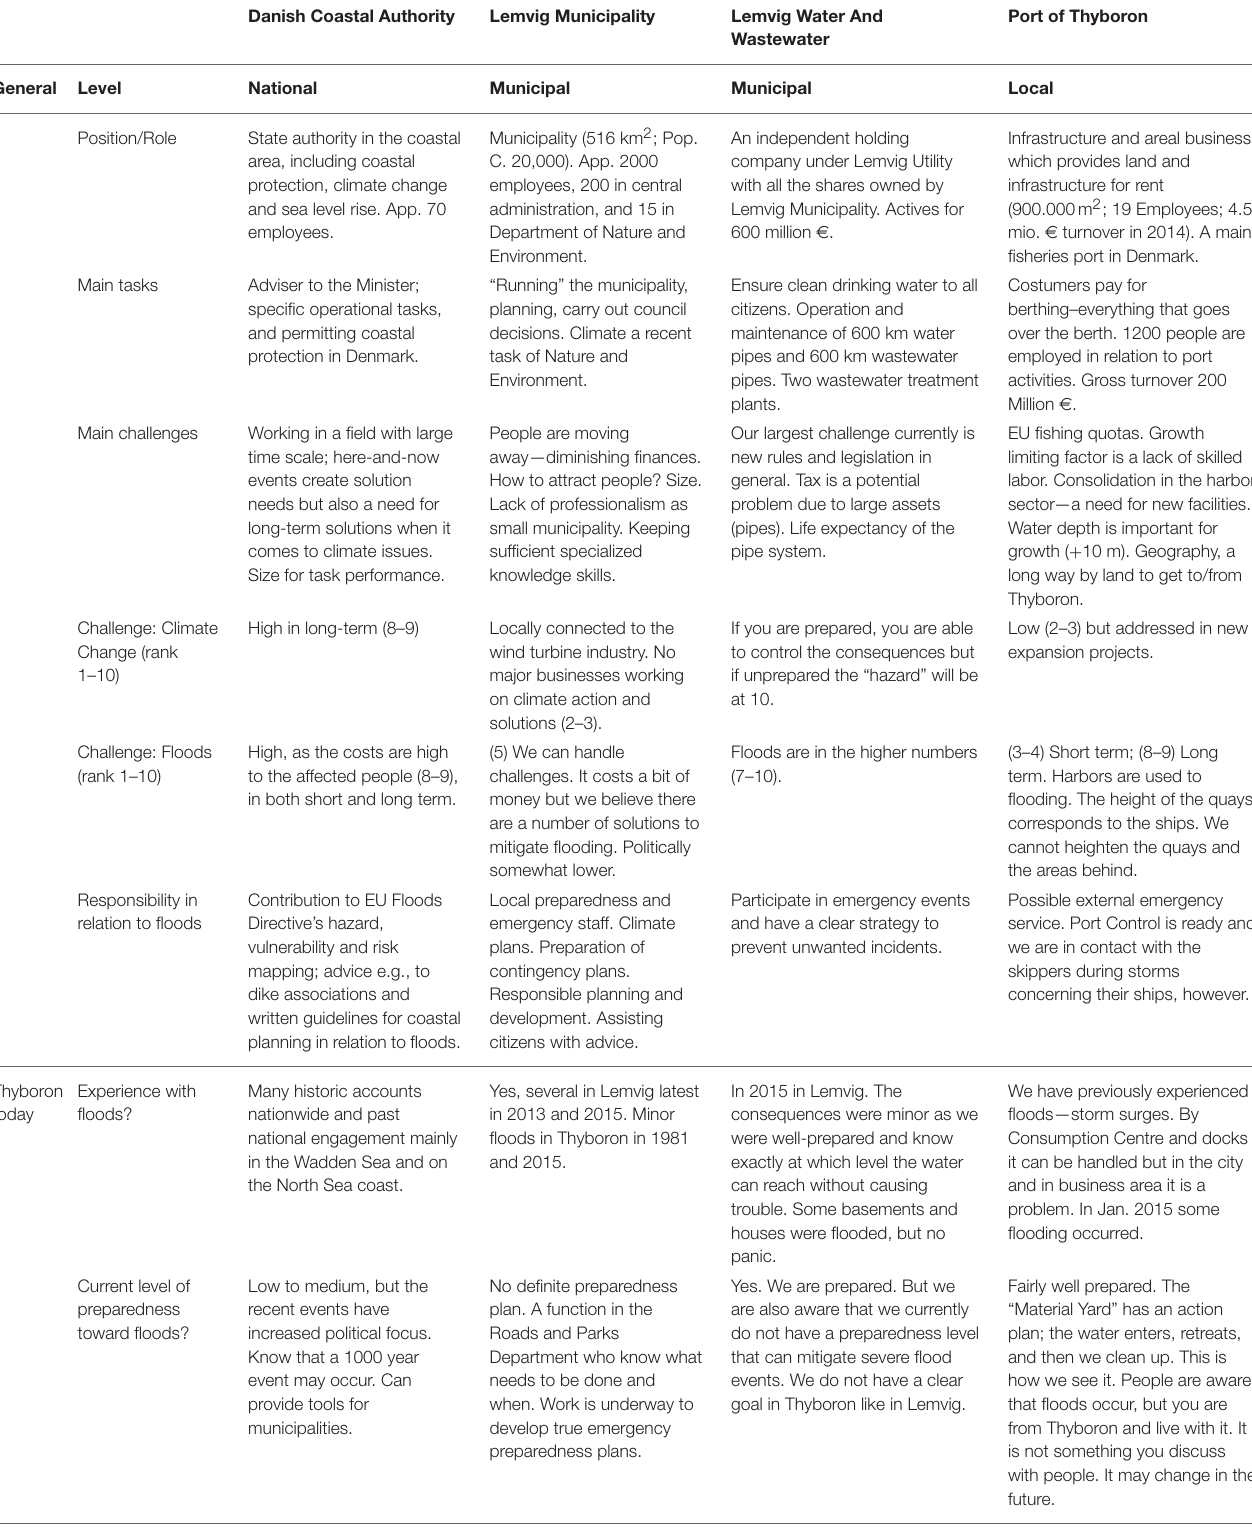
TABLE 2 | Tabulated summary of information provided from semi-structured interviews held with main stakeholders in September